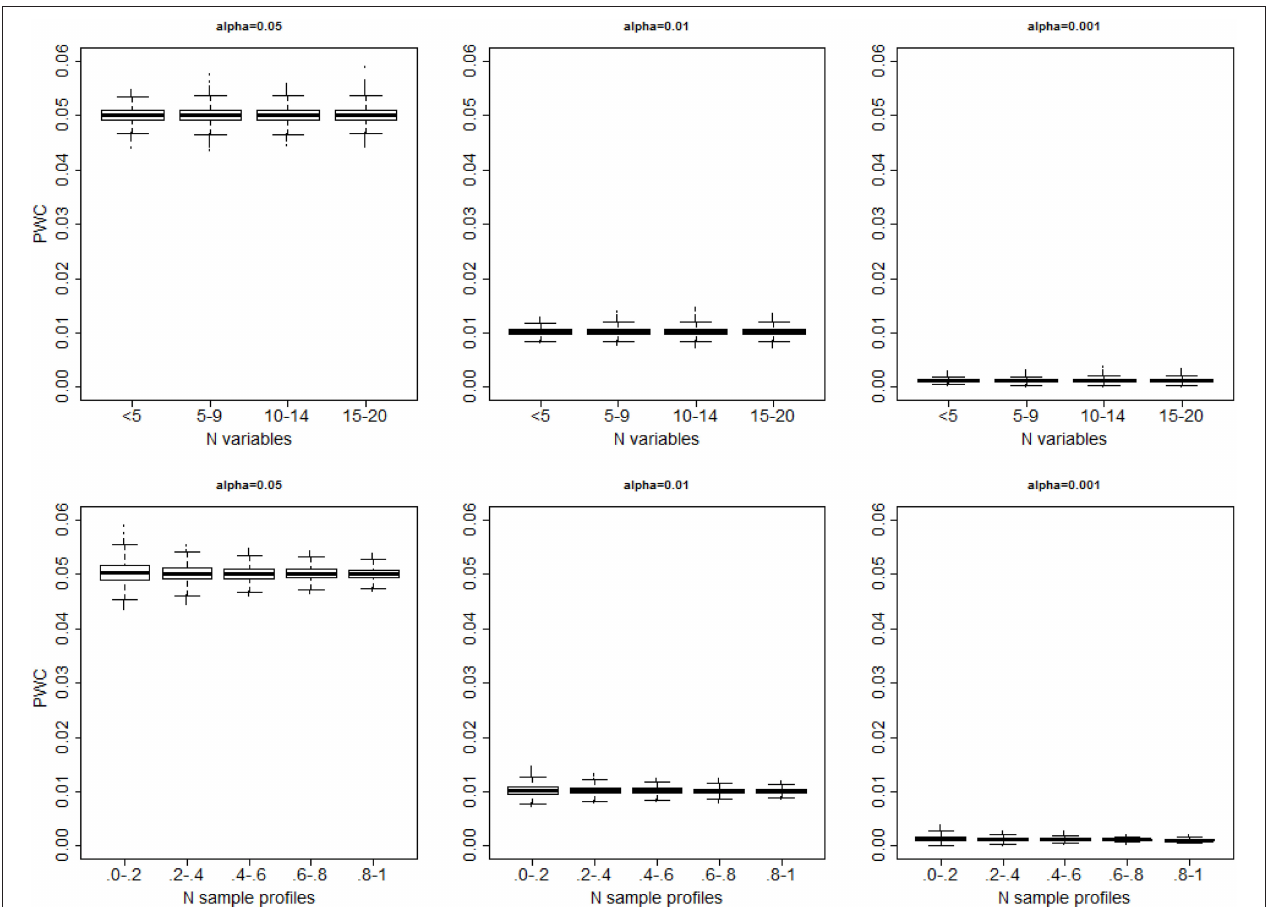
FIGURE 3 | Distribution of the proportion of falsely detected clusters PWC = ( ˆ n cq − 1) / ( n s − 1) for different significance levels ( α = 0.05: left panel; α = 0.01; mid panel; α = 0.001 right panel), vs. the number of variables (top panels) and number of sample profiles generated in 10,000 simulations (bottom panels). The number of sample profiles are presented in quantiles ranges. In each set, data were generated from one cluster, and cluster detection was based on cutting the dendrogram with observed distances D o using the percentiles of the resampling-based reference distribution D e .